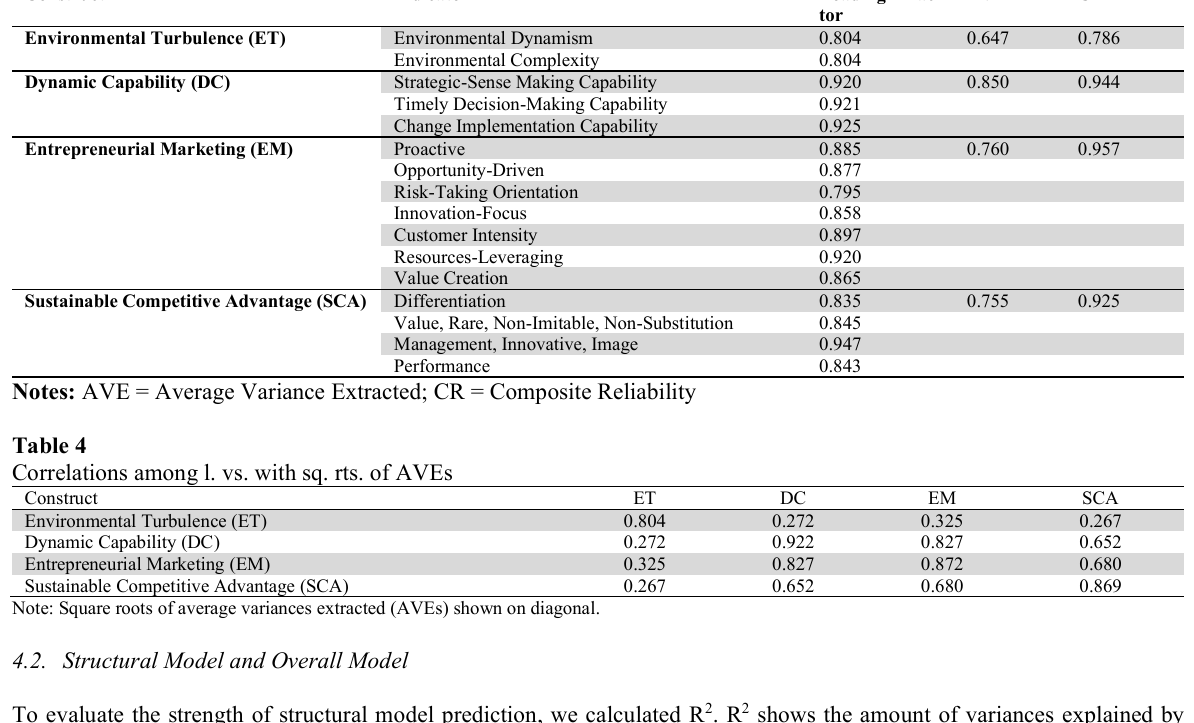
Measurement Model Construct